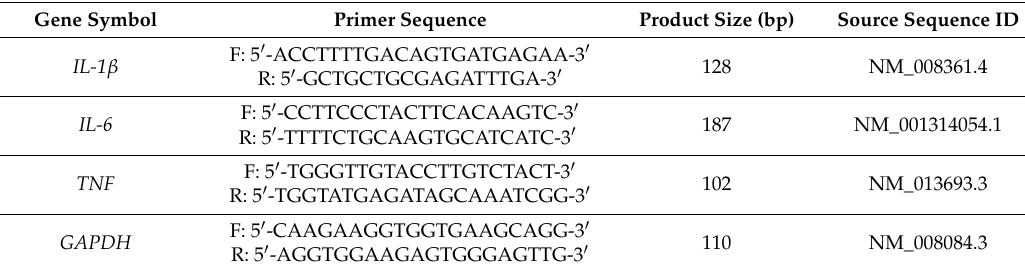
Table 1. Primers used for quantitative real-time PCR